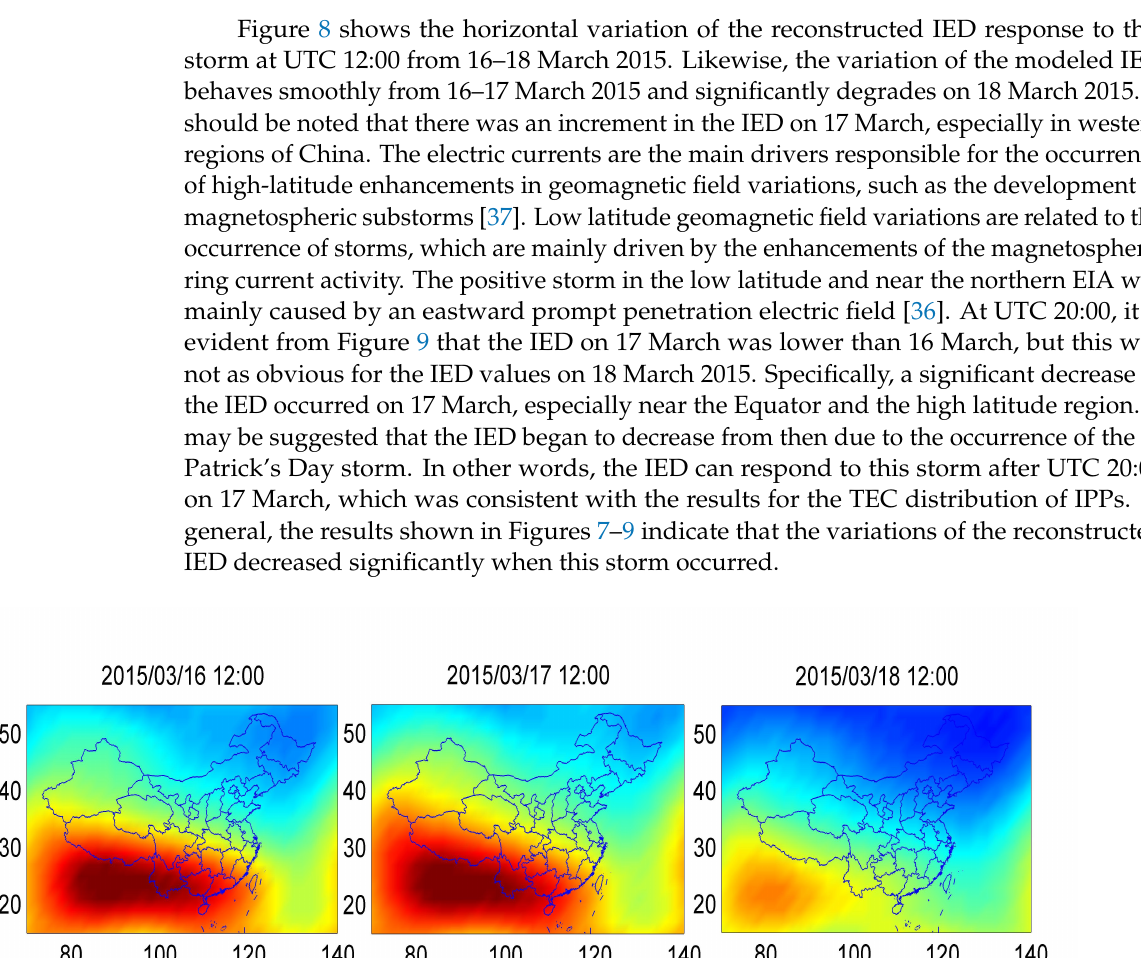
Figure 7. Horizontal distribution of IED at UTC 2:00 from 16–18 March 2015 (H = 350 km).